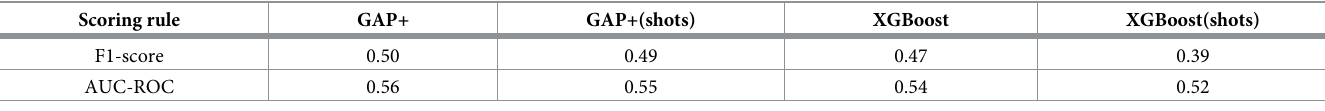
Table 6. Models performance with different non-rare match statistics. Scoring